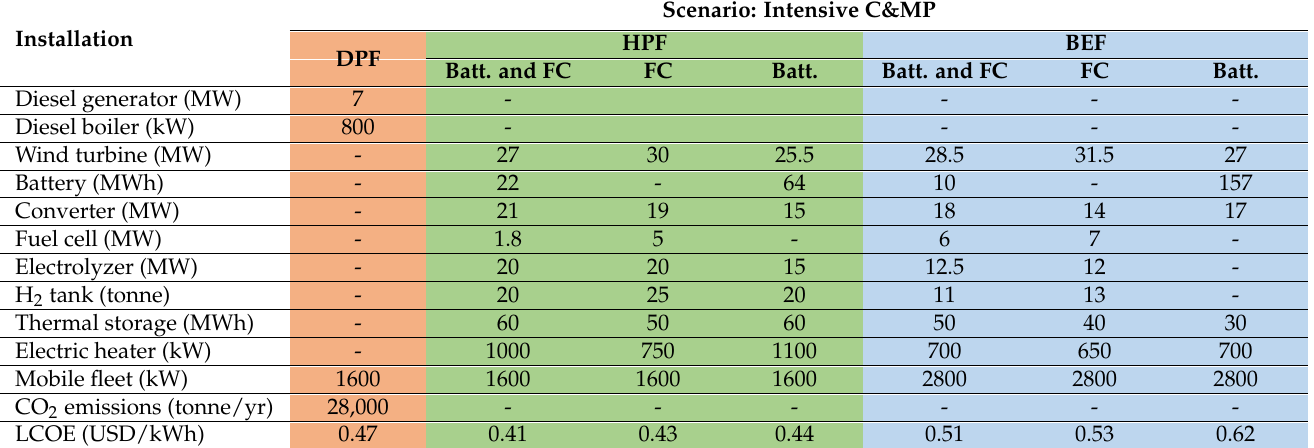
Table 4. Installation capacities and economic–environmental results for intensive C&MP scenario in 5MW modular size